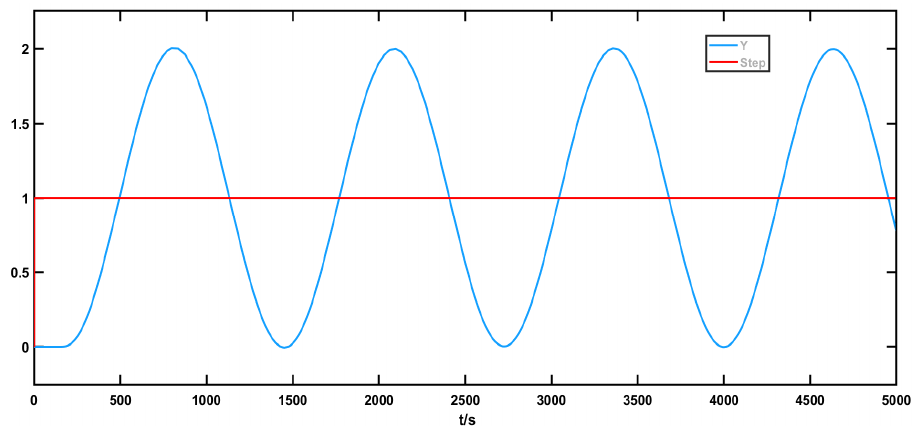
Figure 9. Dual-Locus Diagram of 𝐿(𝑠) and −𝑒 (cid:2869)(cid:2873)(cid:2871)(cid:3046) . When 𝐾 takes different values, 𝜔 (cid:3030) will have different stability regions. Using the above method, we calculate the stability region when 𝐾 takes different values. The results are shown in Figure 10.